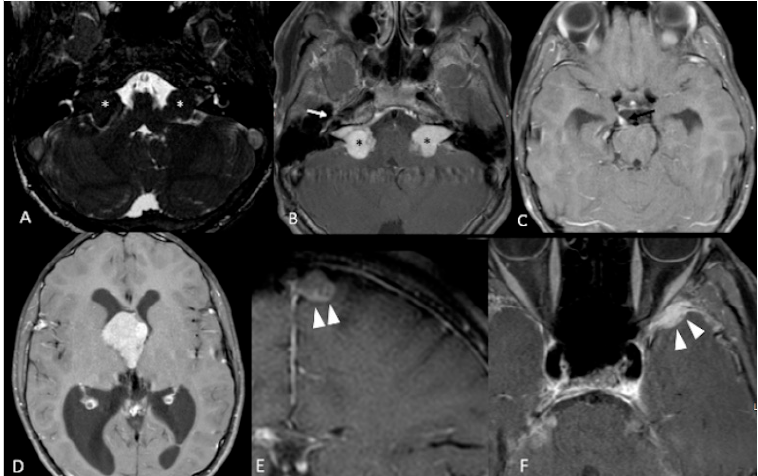
Figure 3. 12-year-old boy with NF2. Contrast-enhanced T1-weighted-Fat saturation MR images ( B , F ) show avidly enhancing masses involving cerebellopontine angles and internal auditory canals (black asterisks in ( B )) with associated T2 hypointensity on axial high resolution T2 FIESTA (white asterisks in ( A )), consistent with bilateral vestibular schwannomas. Also noted are asymmetric enhancement and enlargement of right geniculate ganglion of right CN7 (white arrow in ( B )) and right CN3 (black arrow in ( C )) consistent with additional schwannomas. Large third ventricular meningioma with obstructing hydrocephalus ( D ). Additional left parafalcine and left sphenoid wing meningiomas are noted (arrowheads in ( E , F )).